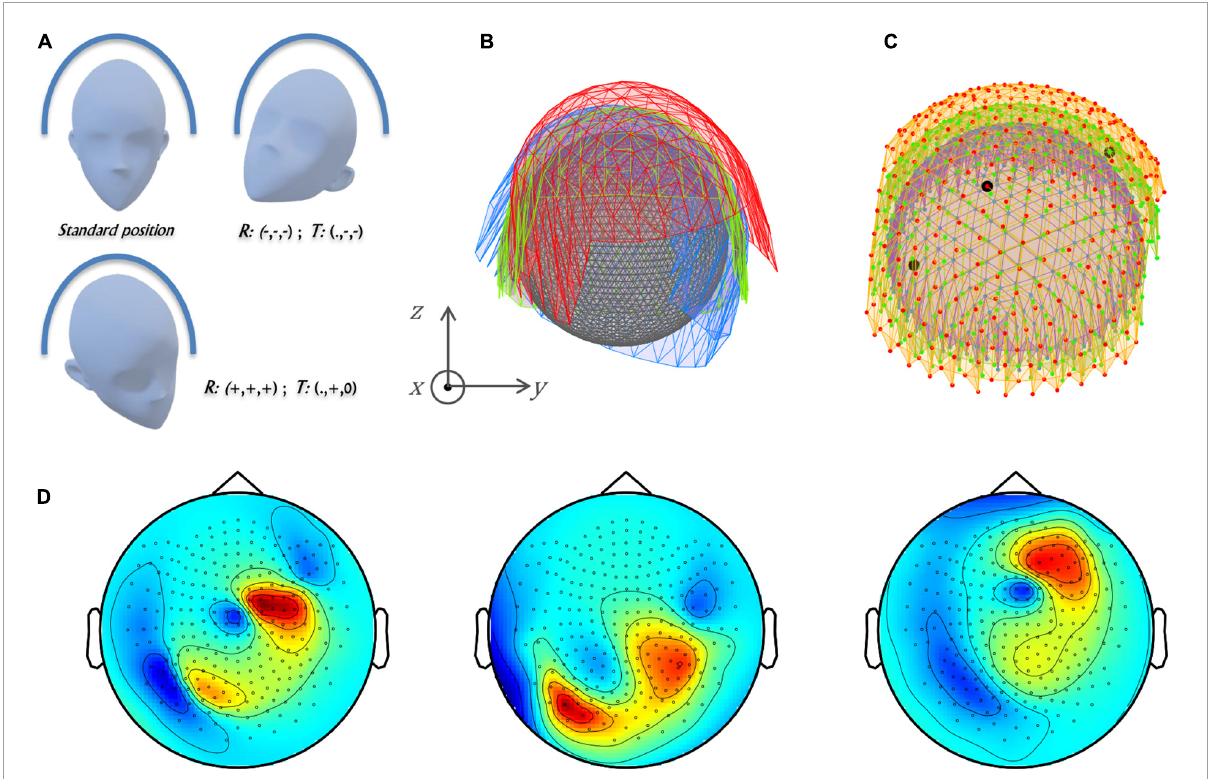
FIGURE1 Virtual MEG helmet construction and source model explained. (A) The translations [T] and rotations [R] of the head of the subject inside the MEG helmet translate to (B) the counter movements of the MEG sensor arrays while the head remained static. In part I simulations, the coordinates of the sensors were translated (15, 15, 15) mm and rotated in (20 20 20) ◦ (red) as well as (–15, –15, 0) mm and rotated in (–20, –20, –20) ◦ (blue) in relation to the standard helmet position (0, 0, 0) (green). The combination of green and red MEG arrays represents VMHa, while the combination of all three arrays represents VMHb. The spherical head model positioned inside the VMH is portrayed in gray. (C) A three-layer spherical grid (10 mm between layers), covering the volume of a spherical head model (inner layer: purple, outer layer: orange, middle: lime). Three black dots mark the locations of three dipoles within the grid in a particular simulation out of the 1,000 performed that consisted of three dipoles. (D) Sensor space representations as 2D topographical maps of the forward projections of all three dipoles presented in panel (C) . Each map presents a 248 MEG array: left map–standard helmet [green in panel (B) ], middle map—red MEG array in panel (B) , right map—blue MEG array in panel (B)